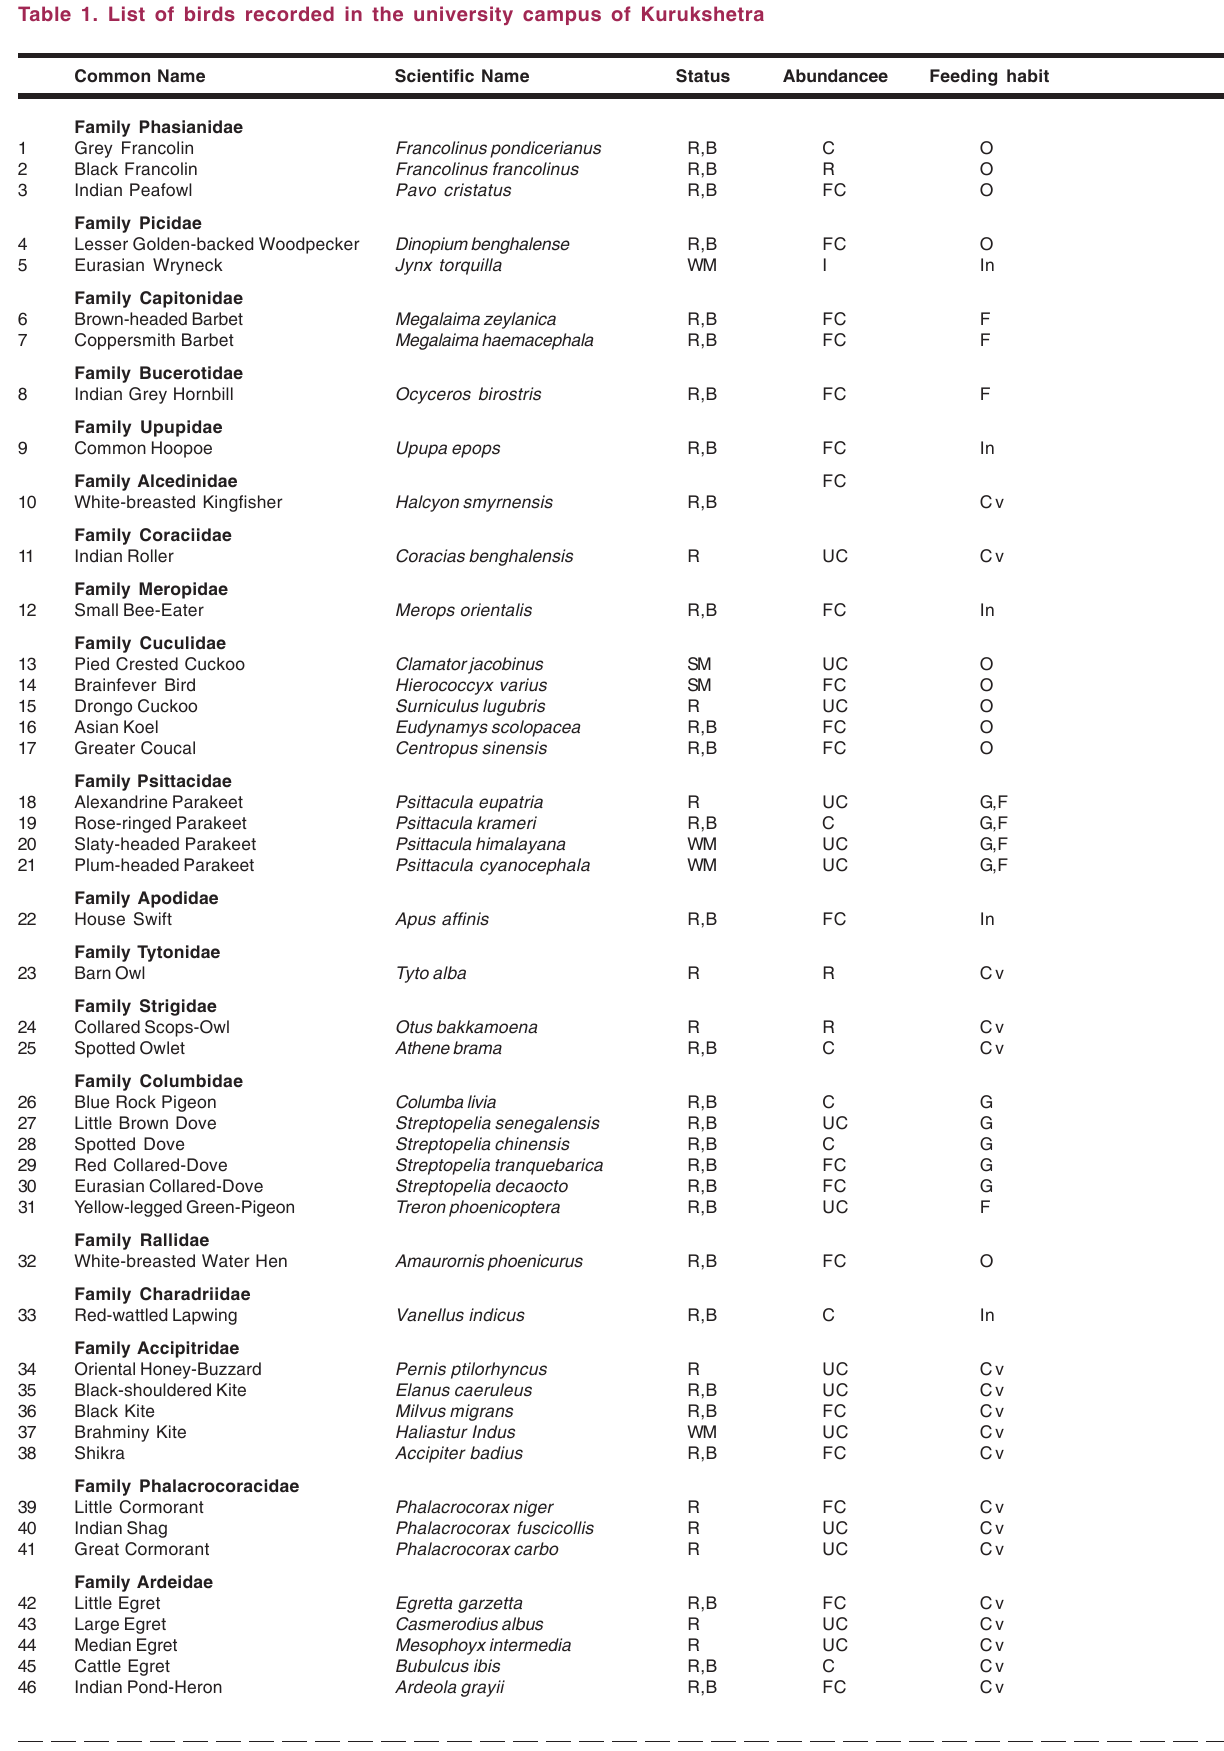
Table 1. List of birds recorded in the university campus of